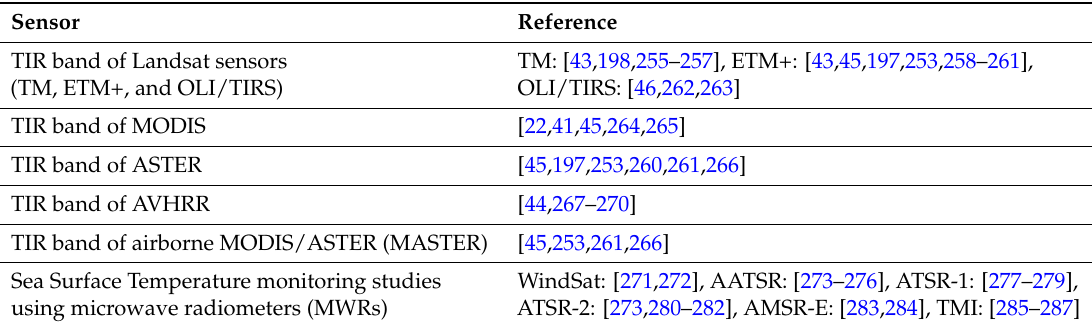
Table 10. Infrared thermal band applications to quantify the water